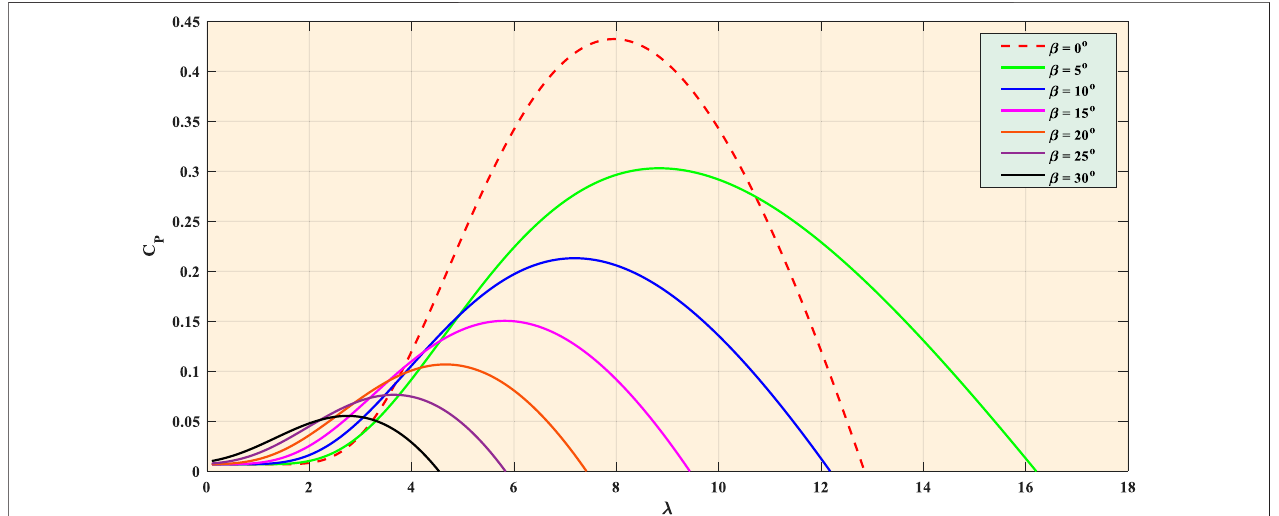
FIGURE 1 | Relationships between wind energy utilization coef fi cient and tip speed ratio under various pitch angles.